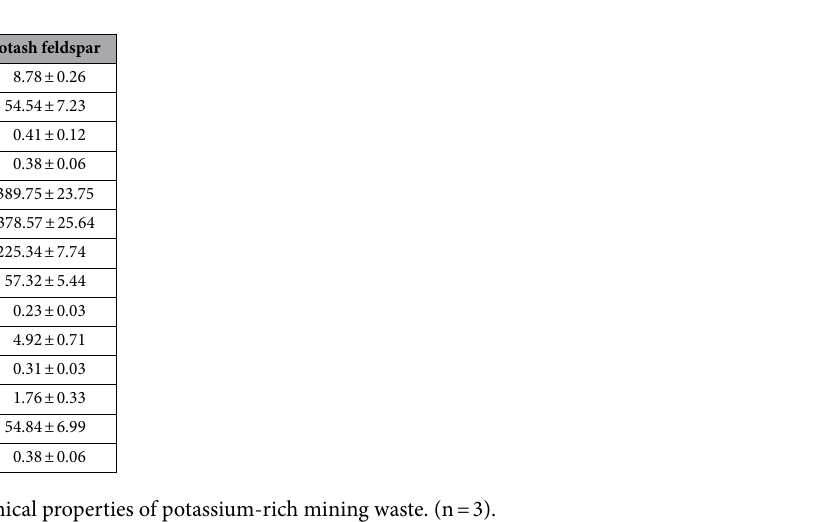
Table 3. Physicochemical properties of potassium-rich mining waste. (n =